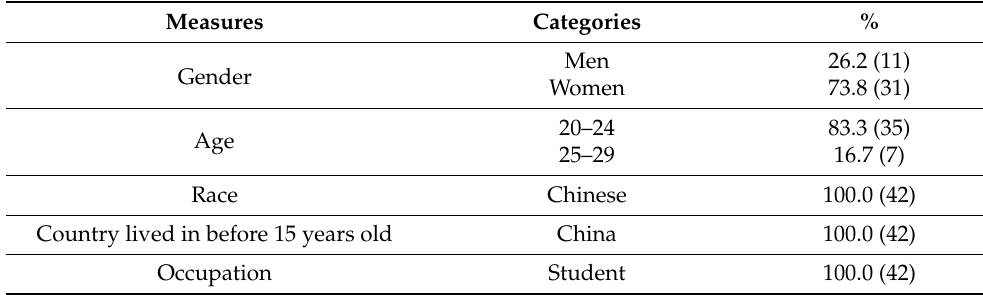
Table 2. Socio-demographic information of participants (%).